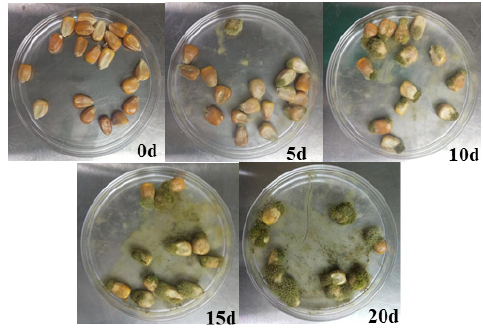
Figure 3. Growth of Aspergillus flavus on Corn.